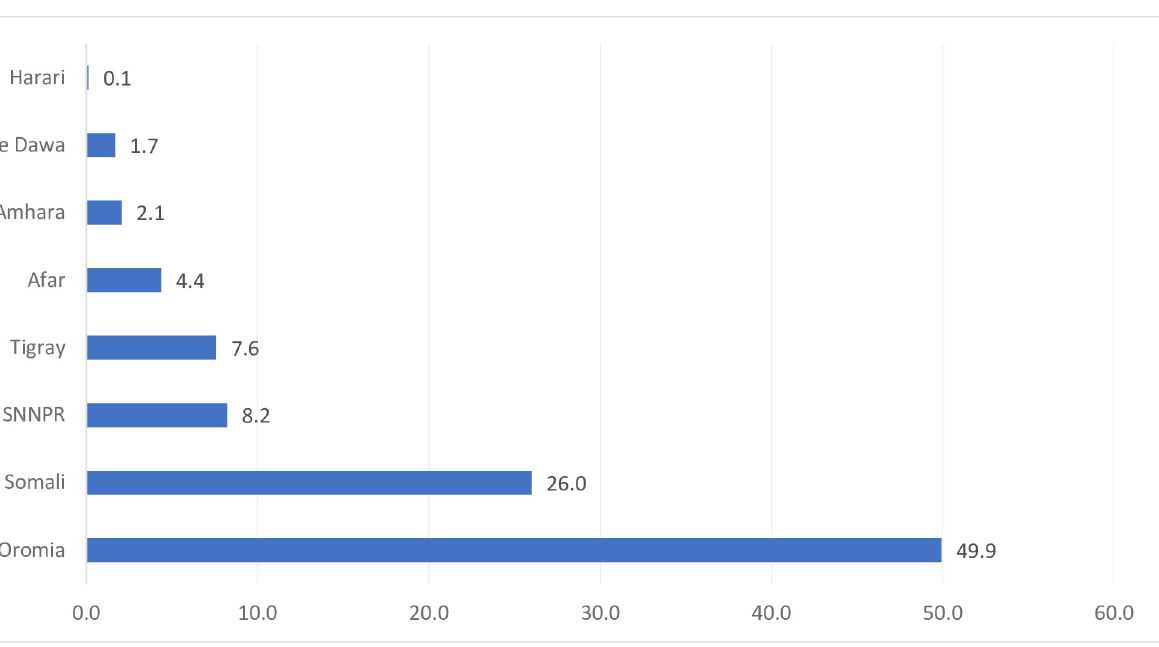
PLOS ONE | https://doi.org/10.1371/journal.pone.0242807 December1,